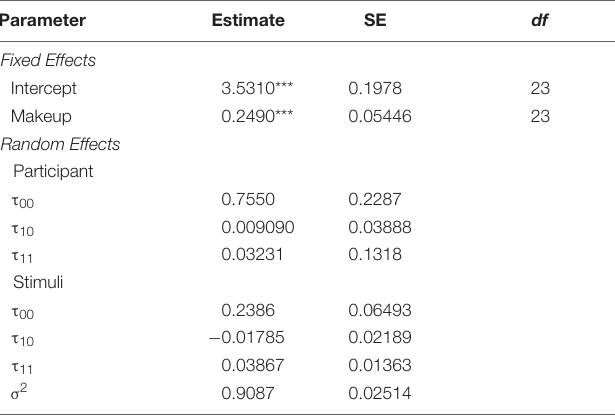
TABLE 1 | Parameter estimates for multilevel model predicting Attractiveness ratings from Makeup